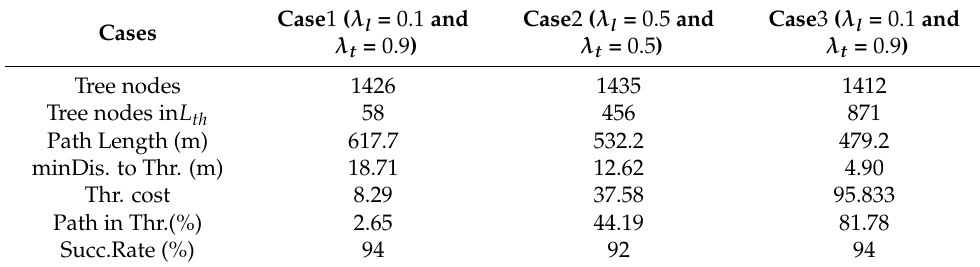
Figure 5. Directed tree graph and path of UAV in Case 3, i.e., λ l = 0.9 and λ t = 0.1: ( a ) 3D view of Case 3; ( b ) 2D top view of Case 3. Table 2. Statistical results of the FC-RRT* for three different weights.